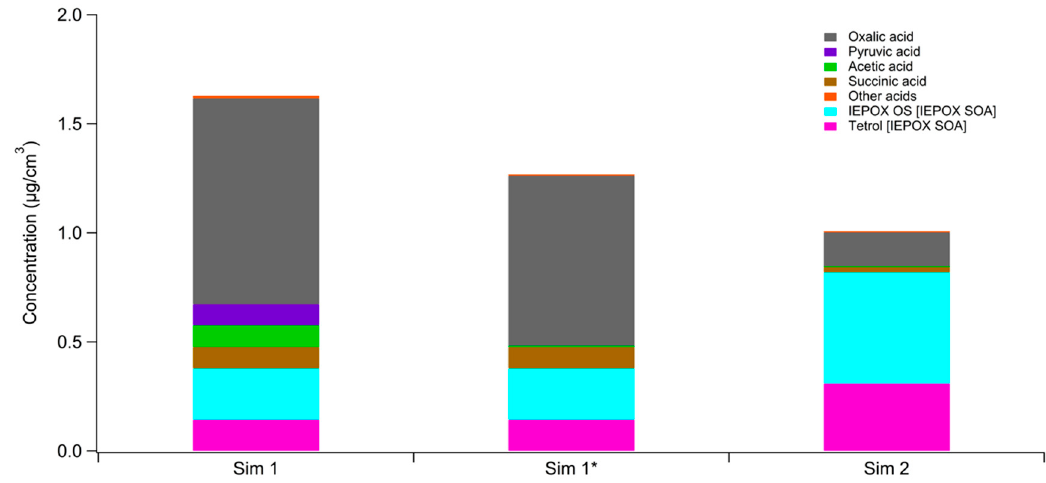
Figure 7. Mass of aqueous phase organic acids and IEPOX SOA at the end of Simulations 1, 1*, and 2 for aerosol pH 1 and cloud pH 4. Concentrations are given in terms of volume of air.